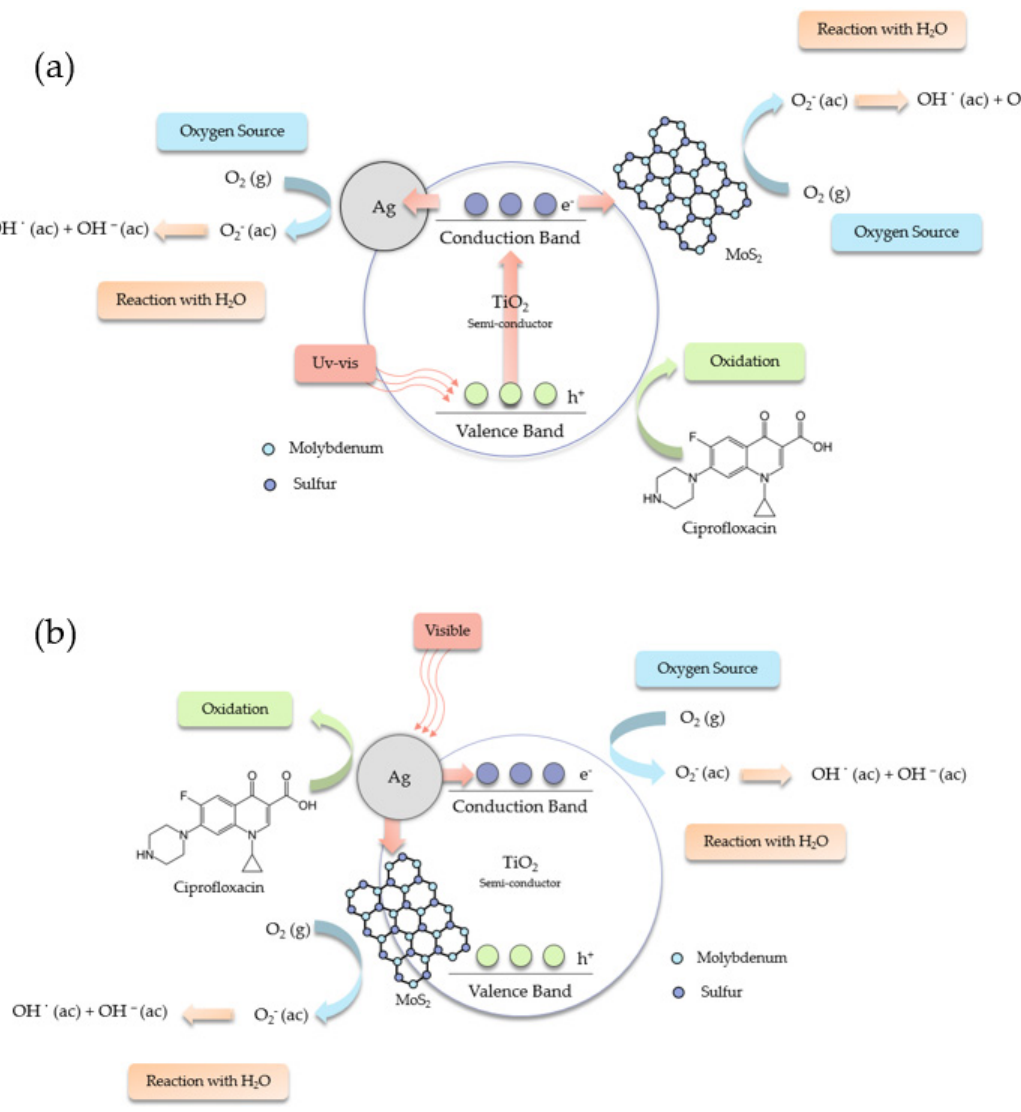
Figure 10. Proposed mechanism for the photodegradation of ciprofloxacin using Ag@TiO 2 -MoS 2 catalysts under ultraviolet ( a ) and visible light ( b ).